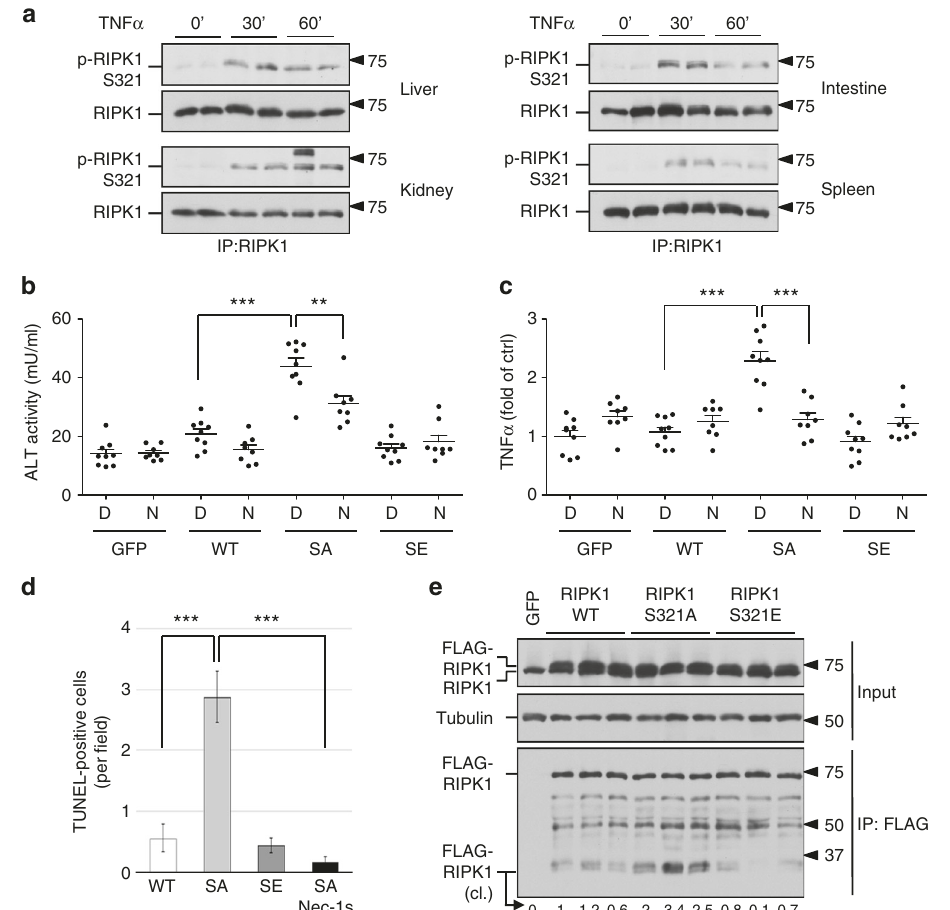
Fig. 4 AAV-mediated RIPK1 S321A mutant expression induces liver damage in vivo. a Phosphorylation of RIPK1 S321 in mice tissues after TNF α injection. 30 µ g TNF α were delivered to mice (8-week-old male) through intraperitoneal injections. Tissues were collected at 30 and 60 min after the injection. RIPK1 was immunoprecipitated from tissue lysates by RIPK1 total antibody. b , c Liver damage in mice induced by AAV-mediated RIPK1 S321A mutant expression. AAVs carrying RIPK1 WT, S321A, S321E or GFP as a control were delivered through tail vein injection. Sixteen days after the AAV injection, the mice were treated with DMSO (D, n = 9) or Nec-1s (N, n = 8) through oral dosing. Four weeks after the AAV injection, plasma and liver samples were collected. ALT b and TNF α ELISA c assays were performed as manufacture ’ s instructions. d TUNEL staining for assessing liver damage induced by AAV-mediated RIPK1 expression. Liver sections were stained with TUNEL and Hoechst. Cells with co-localized TUNEL and Hoechst signals were counted as TUNEL-positive. e AAV-mediated expression of FLAG-RIPK1 variants in liver. The liver lysates were subjected to anti-FLAG immunoprecipitation to differentiate endogenous RIPK1 and ectopic FLAG-RIPK1. Relative intensity of cleaved (cl.) RIPK1 bands was quanti fi ed. Error bar, s.e.m. **, t -test P < 0.01, *** P < 0.001.